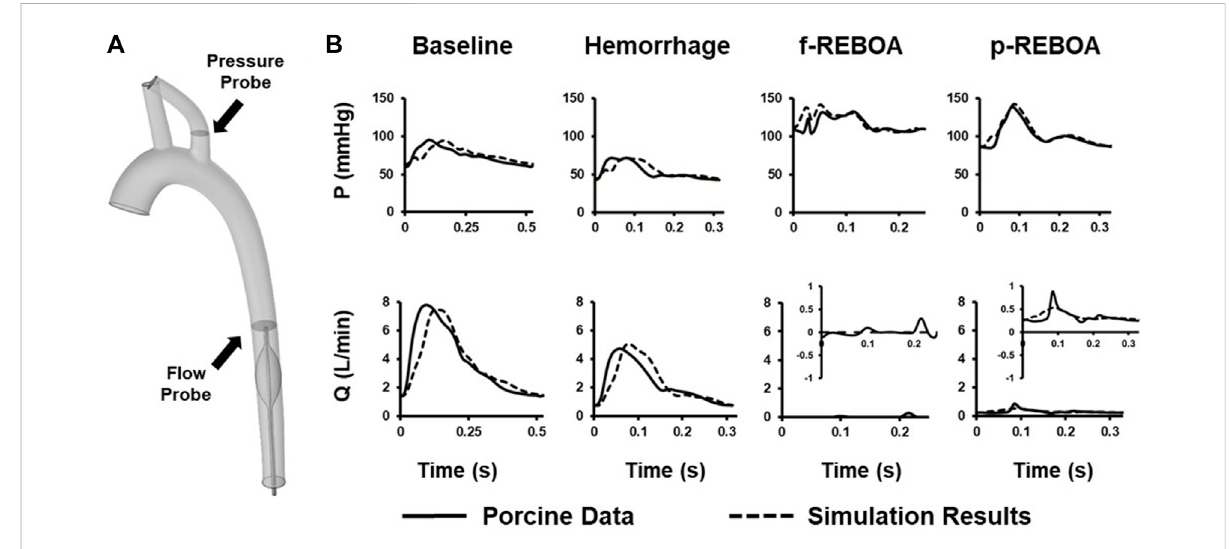
FIGURE 3 CFD Model Calibration. (A) Location of in vivo pressure and fl ow data used to calibrate CFD model on 3-D aortic geometry. (B) Comparison between measured pressure and fl ow data (solid line) and the simulation data (dashed line) calculated at the subclavian artery and thoracic aorta. A zoomed in representation of fl ow rate (Q) for both f- and p-REBOA is provided since recorded and simulated data were within a 1 L/min range. All simulated mean pressure and fl ow data are matched within a 5% error